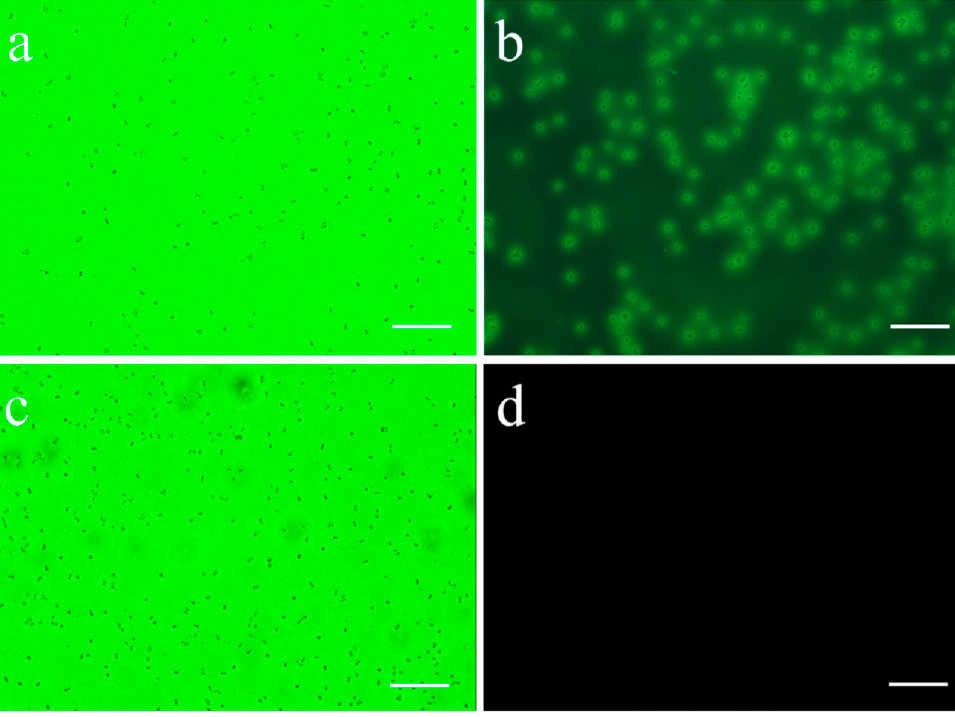
Figure 3. The results of fluorescence microscopy: ( a ) bright field of MG1363-VP1; ( b ) fluorescent field of MG1363-VP1; ( c ) bright field of MG1363-pMG36e; ( d ) fluorescent field of MG1363-pMG36e. (Scale size: 20 μ m).